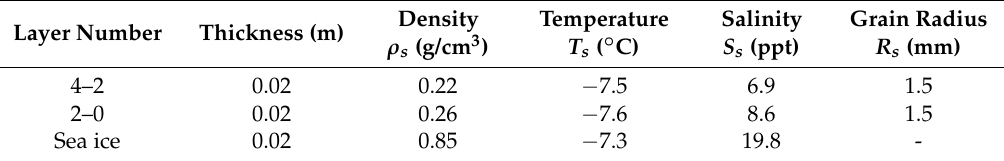
Table 3. Snow cover and sea ice thermophysical properties for the 4 cm snow cover on smooth FYI for 19 May 2012. The total sea ice thickness was 1.3 m, and “sea ice” in the table represent the topmost 2 cm frazil ice core